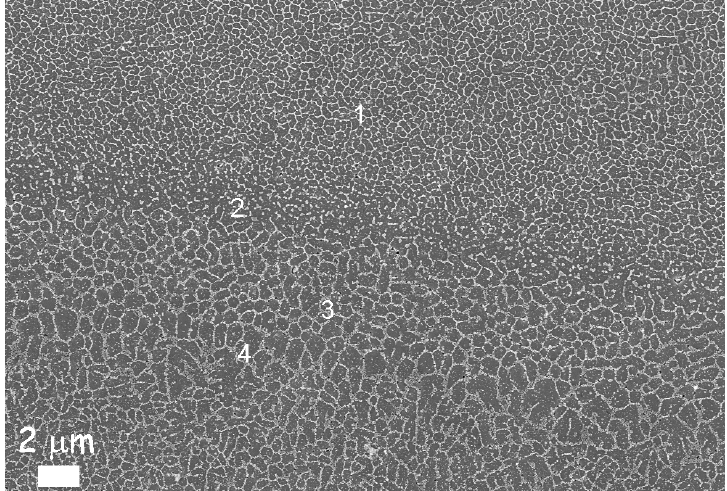
Figure 10. FESEM image of an AlSi10Mg alloy produced by means of the DMLS process in an as-built condition after etching with a Keller reagent: it is possible to observe the different sizes of the cellular-dendritic structures.